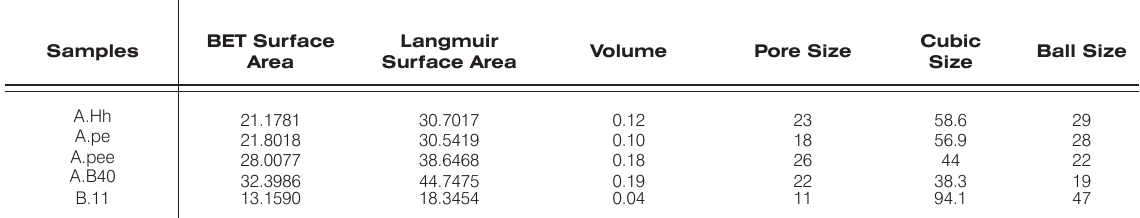
Table 4. The BET results of samples by various methods